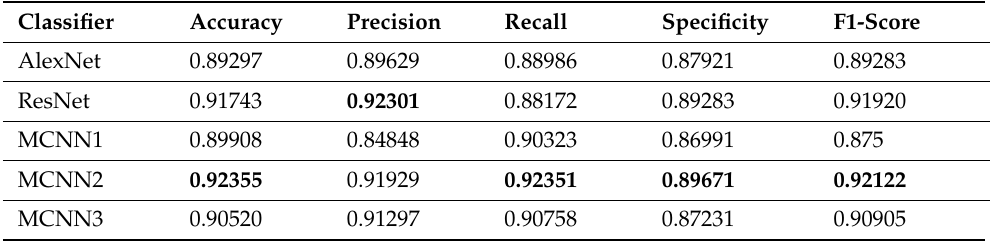
Table 7. Classifications results for denoised